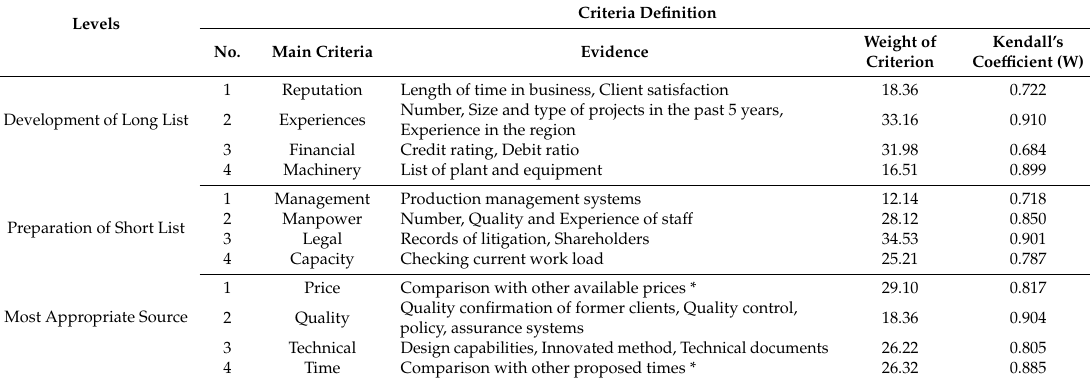
Table 10. Criteria development of Construction Supplier(s) and their weights.